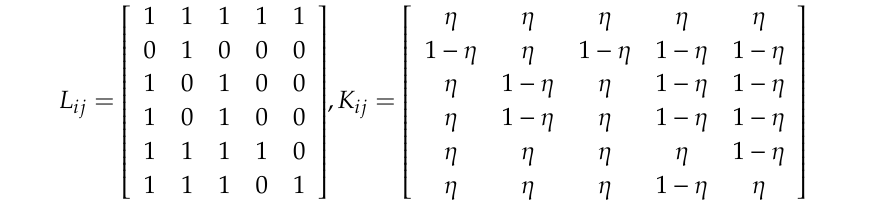
Table 2. Sequential representation of nodes in the DBTRN. EE: Emergency Equipment. Node Components of DBTRN N 1 BS N 2 IR N 3 RP N 4 EE N 5 TT1 N 6